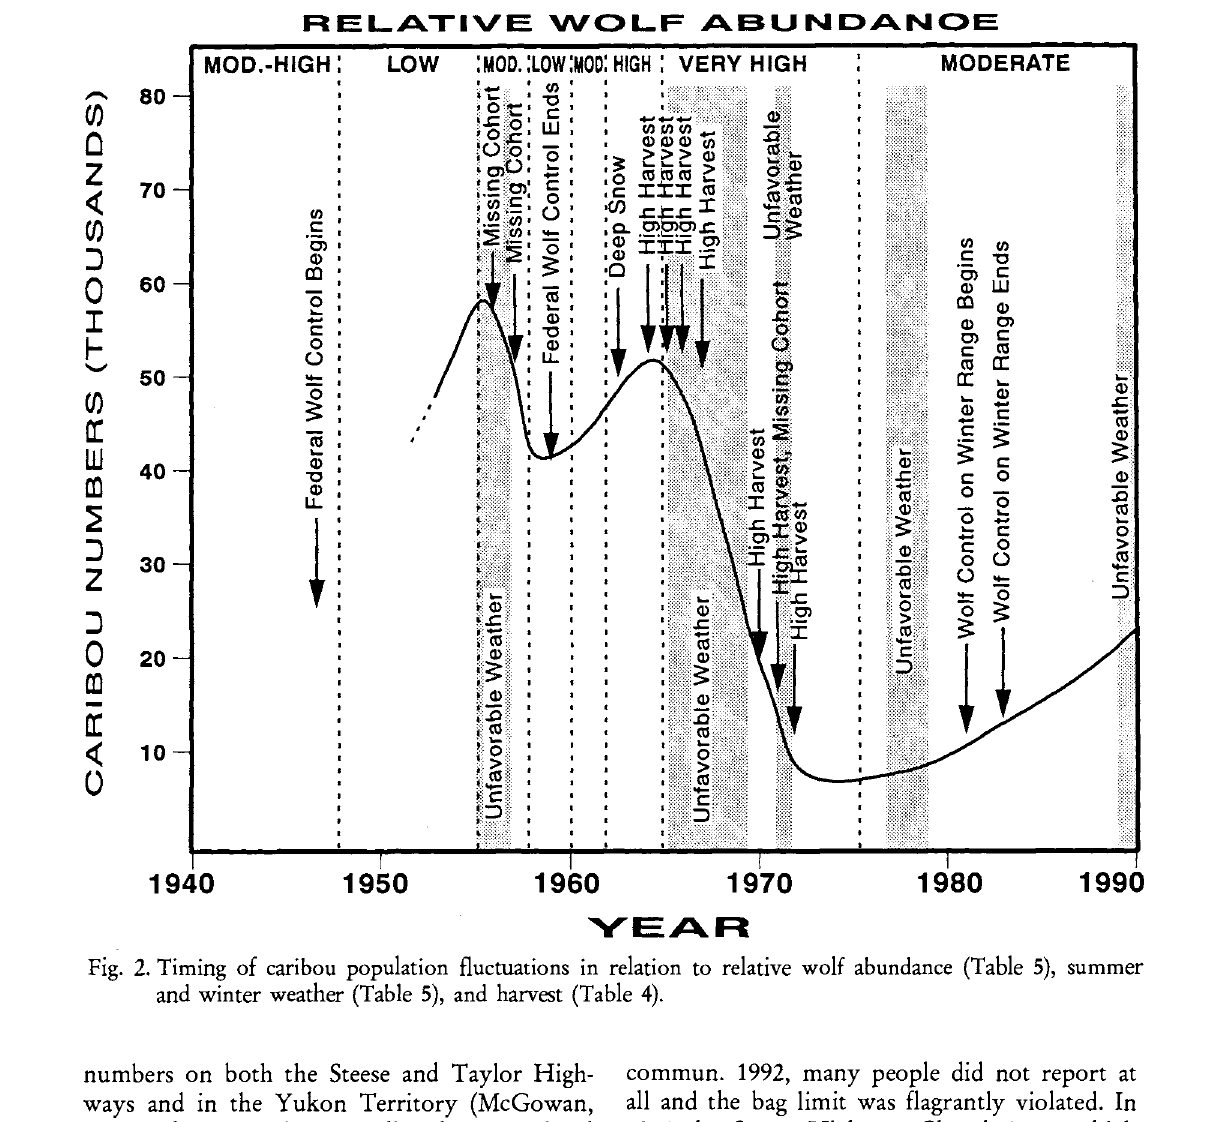
Fig. 2. Timing of caribou population fluctuations in relation to relative wolf abundance (Table 5), summer and winter weather (Table 5), and harvest (Table